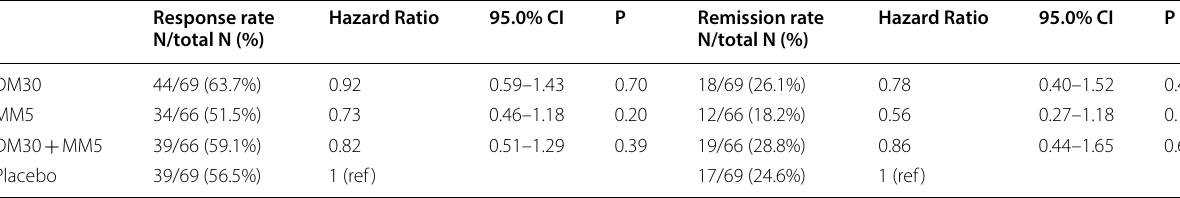
Table 5 Survival analysis according to response and remission